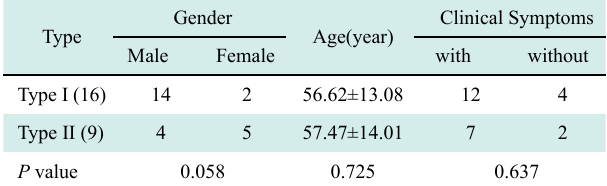
Table 1 Characteristics of patients with type I and II PRCC